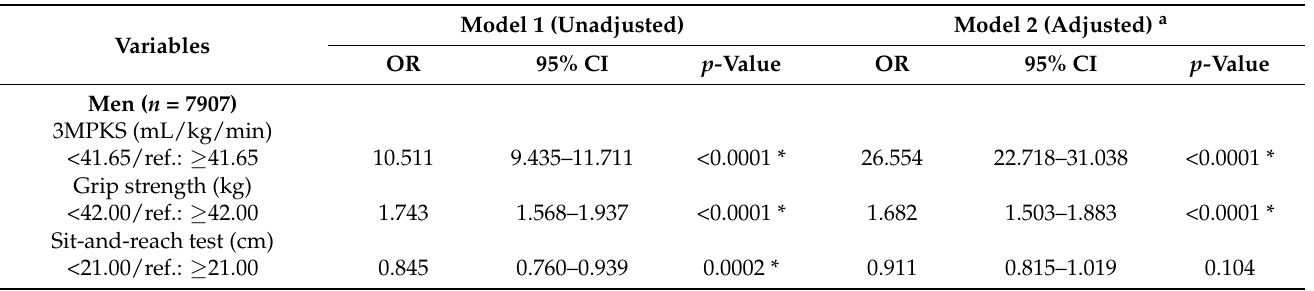
Table 5. Multivariate logistic regression model for BF obesity in relation to the 50th percentiles of physical fitness measurements after adjustment for potential